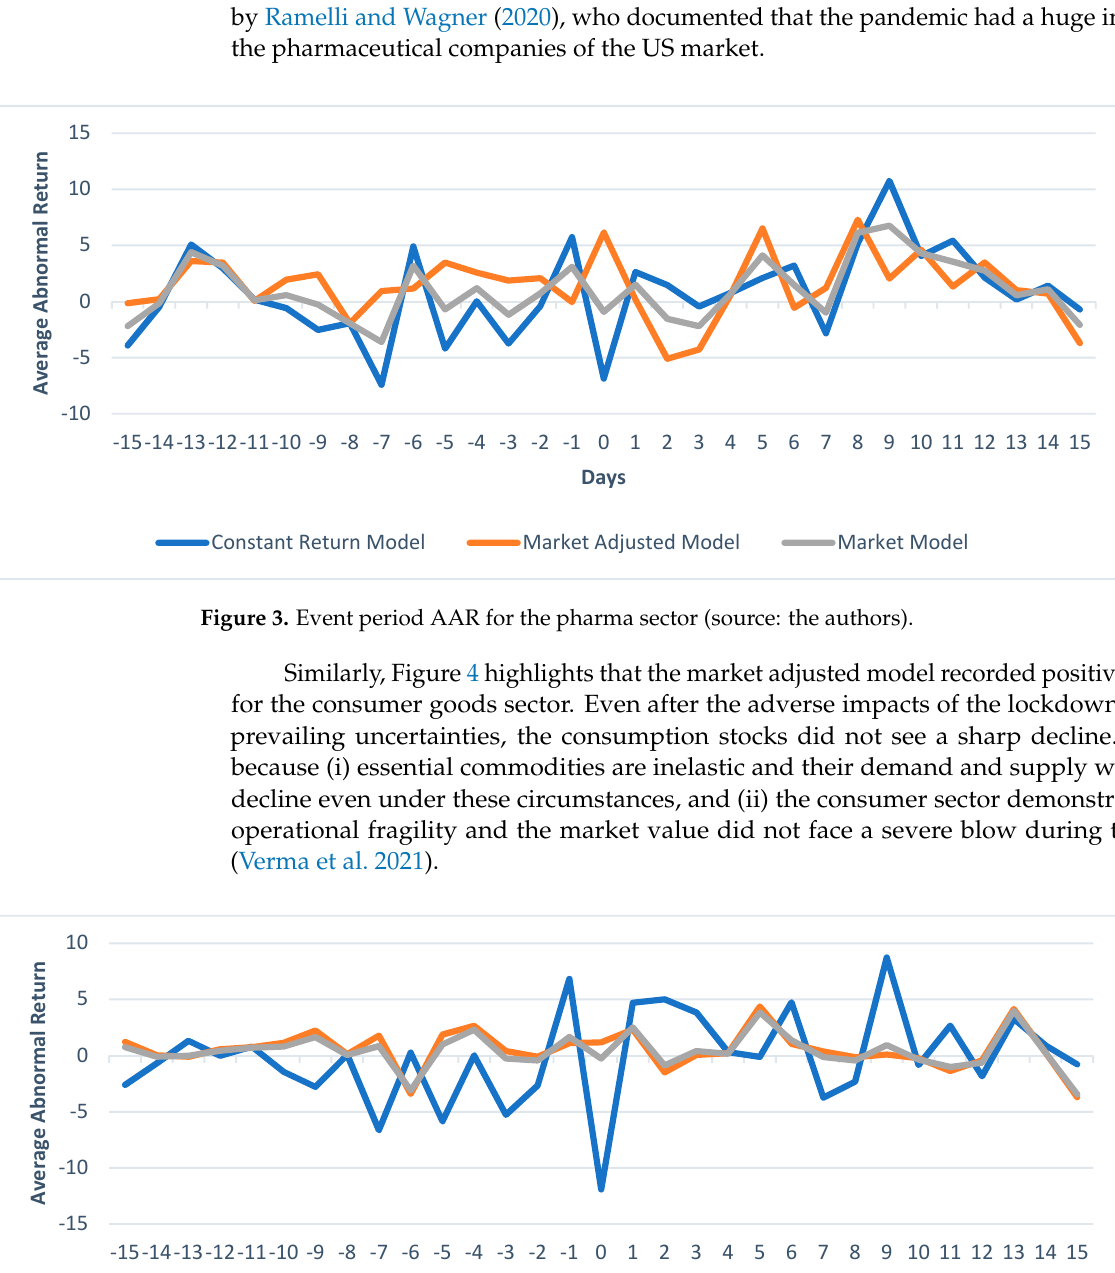
was the worst hit. This sector was negatively impacted due to the anticipation of